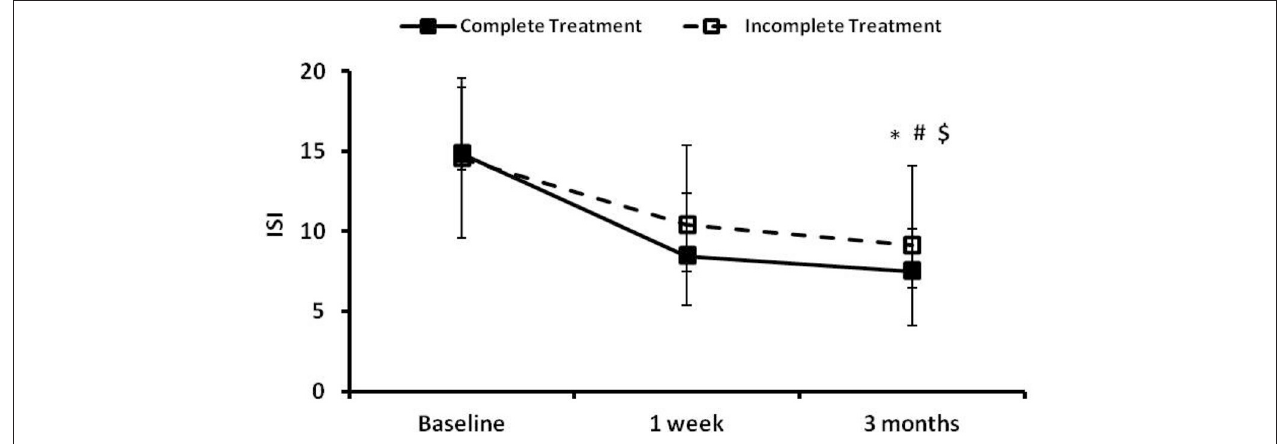
FIGURE 3 | The insomnia severity index (ISI) at the preintervention baseline, and 1 week and 3 months following cognitive behavioral treatments for insomnia (CBTI). *, #, and $ indicate significant differences ( p < 0.05) for the time effect, group effect and group × time effect, respectively. Complete treatment group, n = 58; incomplete treatment group, n =